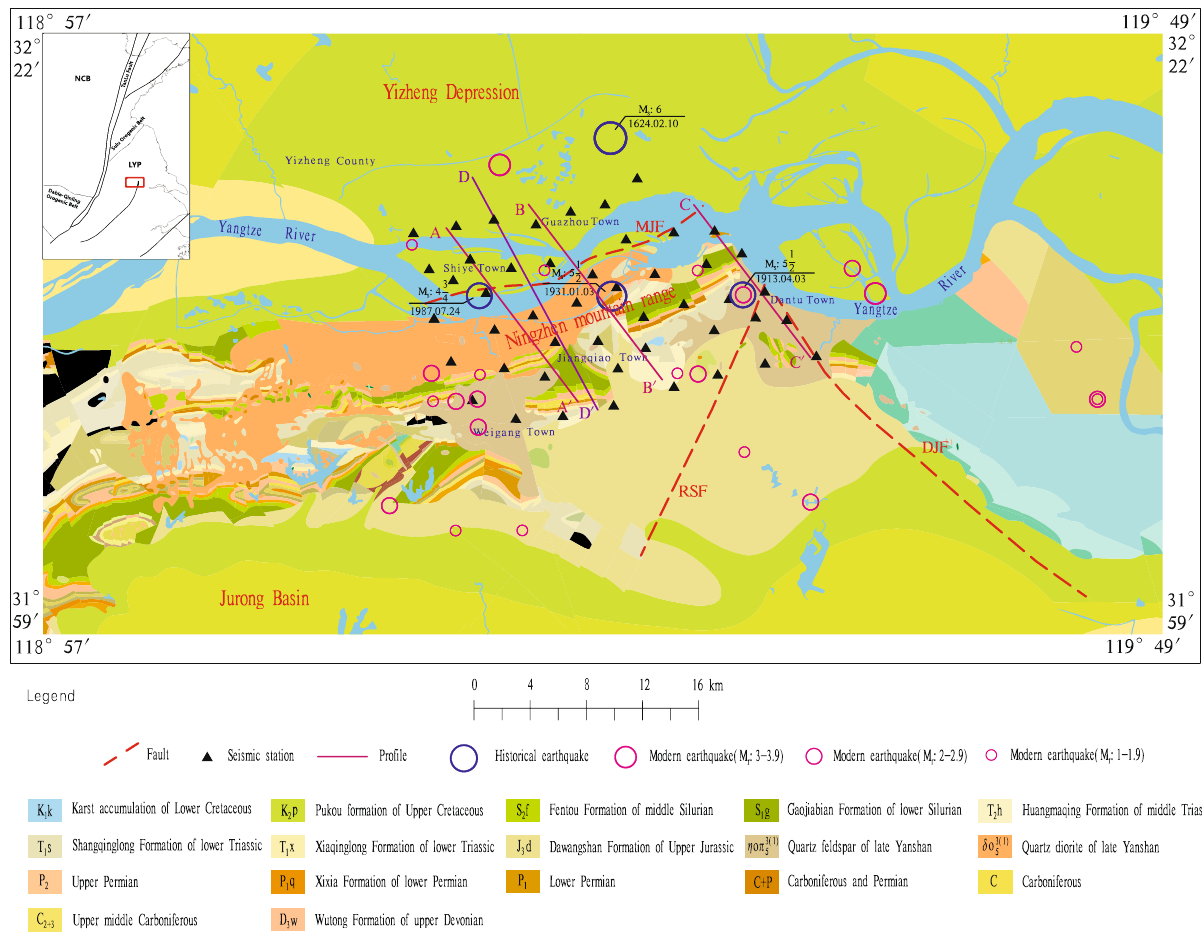
Figure 1. Geologic structure, faults, river systems, earthquake location, and station location in the study area and its adjacent regions. The inset figure shows the locations of the study area and its adjacent regions (red box) and the NCB, LYP represent North China Block, and Lower Yangtze Plate, respectively. (The software used to create the map is MAPGIS 6.7, http://www.mapgi